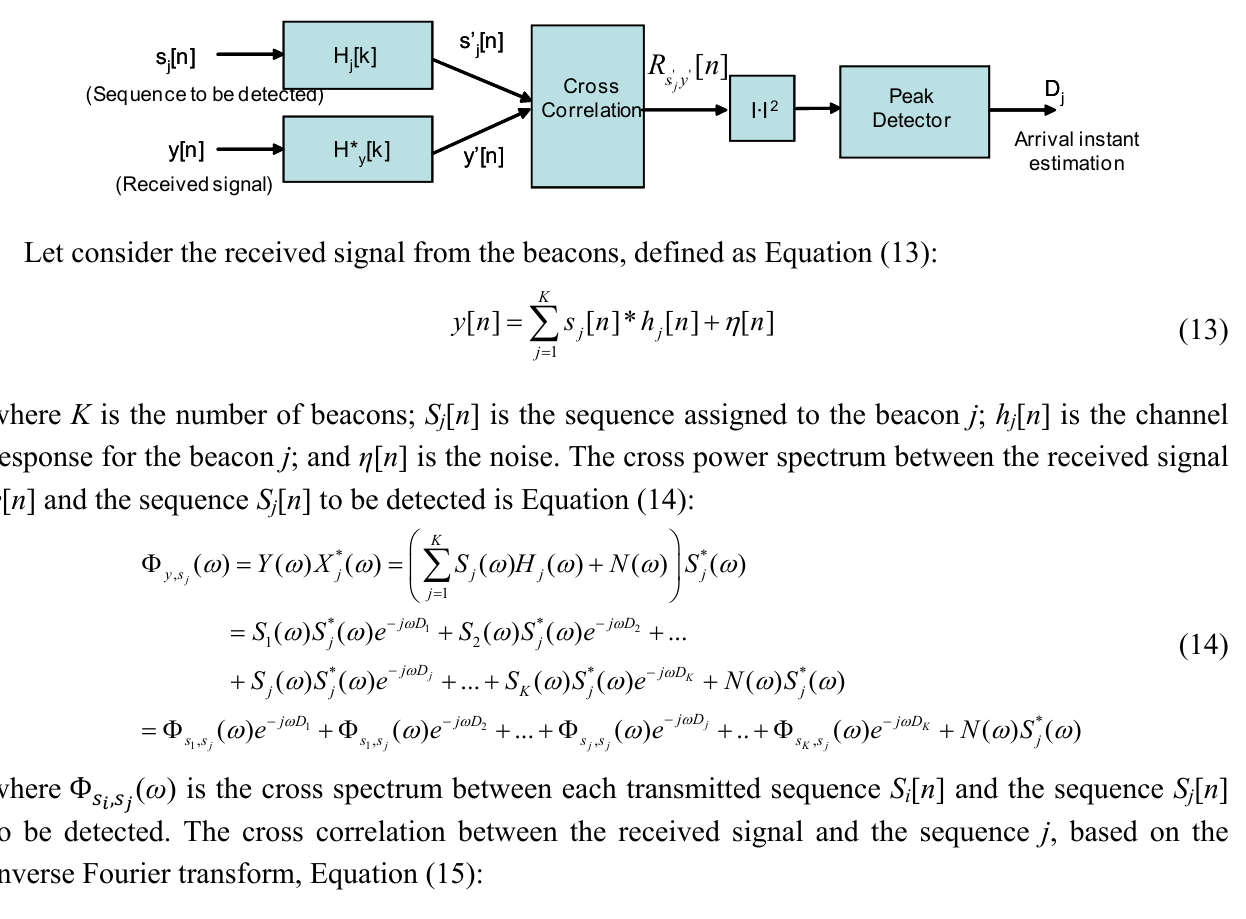
Figure 4. Block diagram of the estimation process of the arrival instant for a sequence j based on